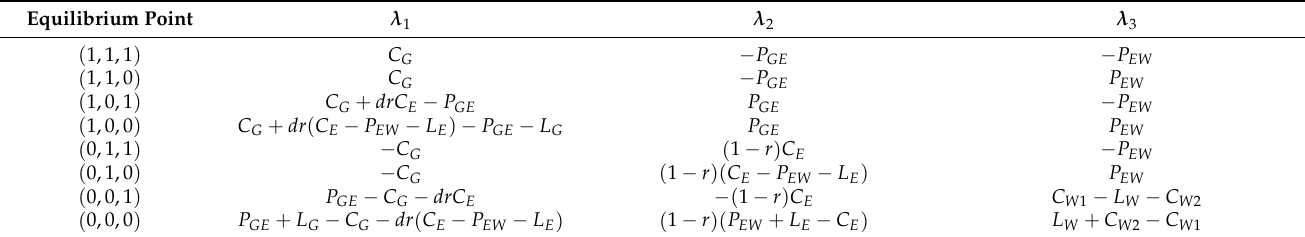
Table 3. Eigenvalues of the Jacobi